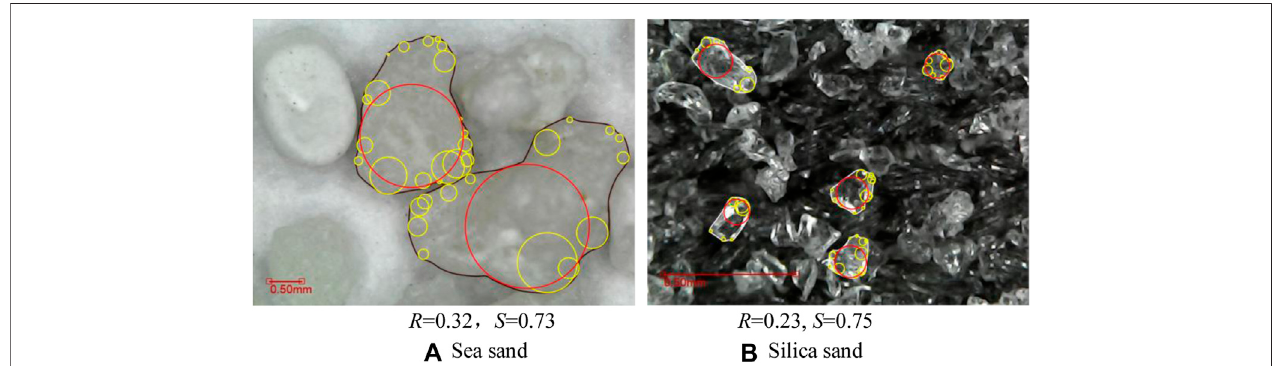
FIGURE 5 | Schematic diagram for the roundness and sphericity calculation of (A) sea sand and (B) silica sand.